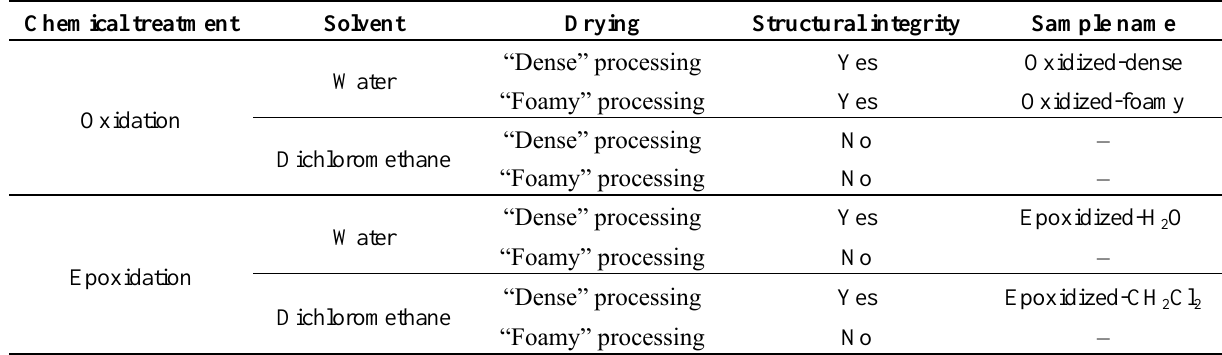
Table 4. Types of buckypapers